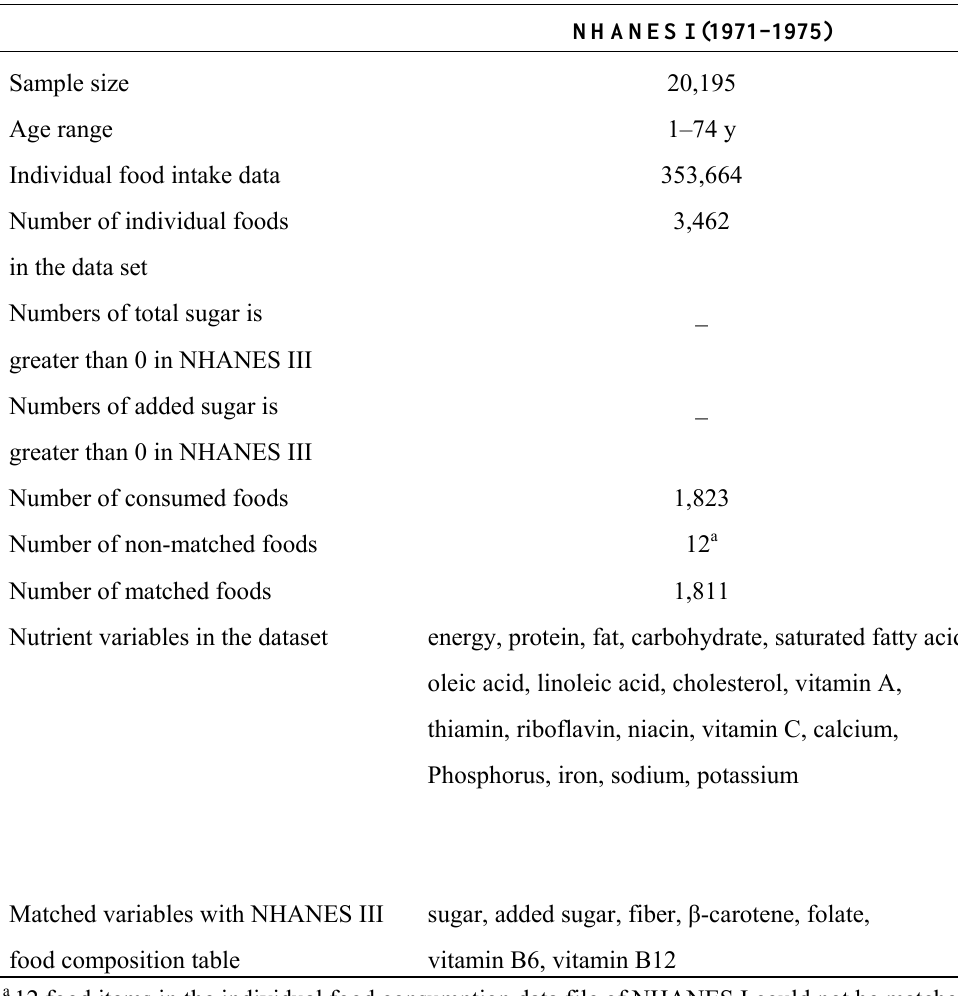
Table1. Characteristics of NHANES I and NHANES III